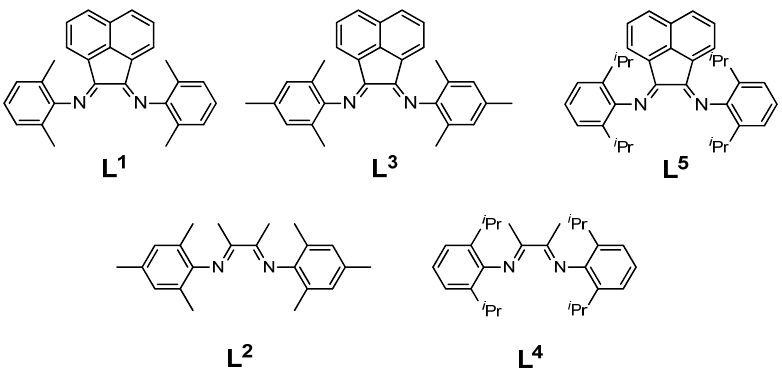
Figure 1. Structures of α -diimine ligands considered in the present work.